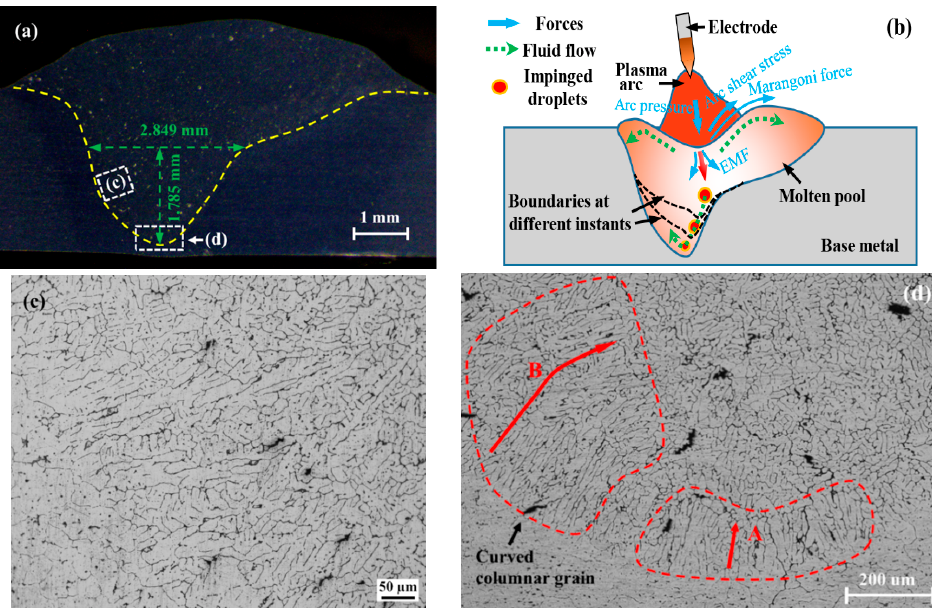
Figure 3. Welding torch inclined from the center line in the transverse section. ( a ) Molten pool profile with the sharp inflection point (SIP) not present on the non-impact action side (NIAS); ( b ) schematic diagram of the molten pool behavior; ( c ) columnar grain on the NIAS in the FLP level; ( d ) shortened columnar grain on the impact action side (IAS) at the shallow level.